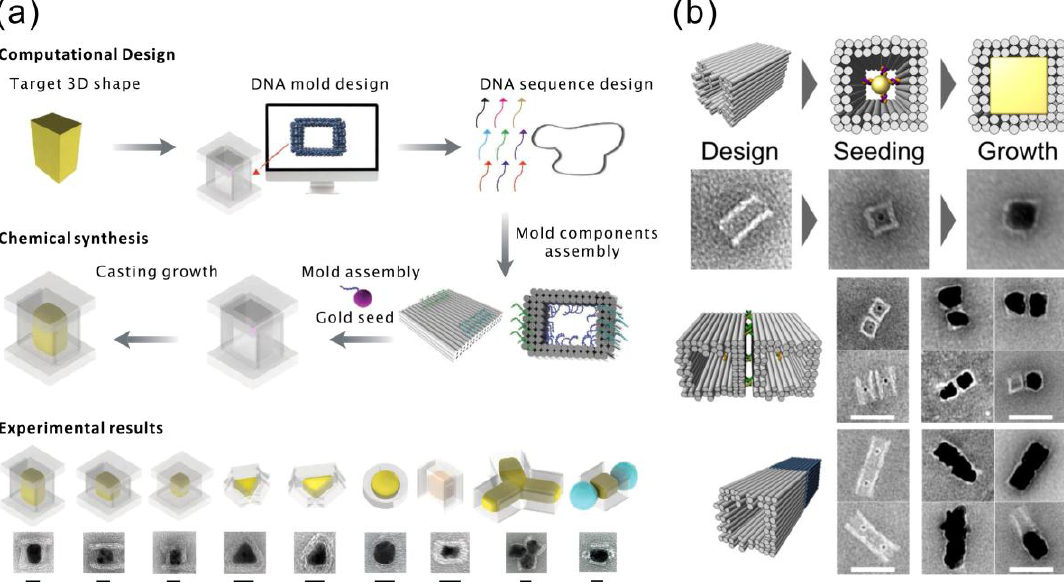
Figure 5. ( a ) Top panel: casting metal particles with prescribed 3D shapes using programmable DNA nano-structure molds. Bottom panel: experimental results of the cast procedure. The scale bars are 20 nm [98]. ( b ) Top panel: schematic views and TEM images of the AuNP seed grown inside the DNA origami mold without the lid. Bottom panel: side-by-side and head-to-tail designs. All scale bars correspond to 50 nm [99]. (a) is reproduced with permission from [98]. Copyright The American Association for the Advancement of Science, 2014; (b) is reproduced with permission from [99]. Copyright American Chemical Society, 2014.